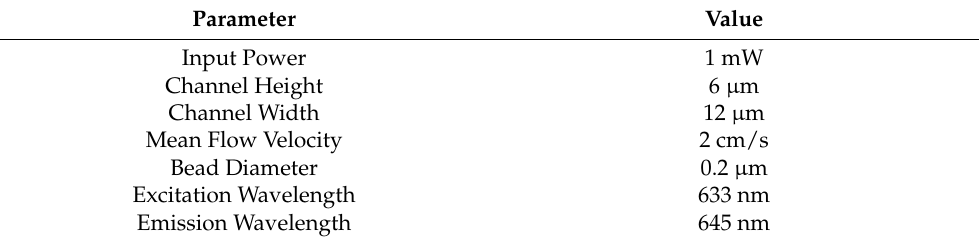
Table 1. General model parameters constant across all studied design iterations.